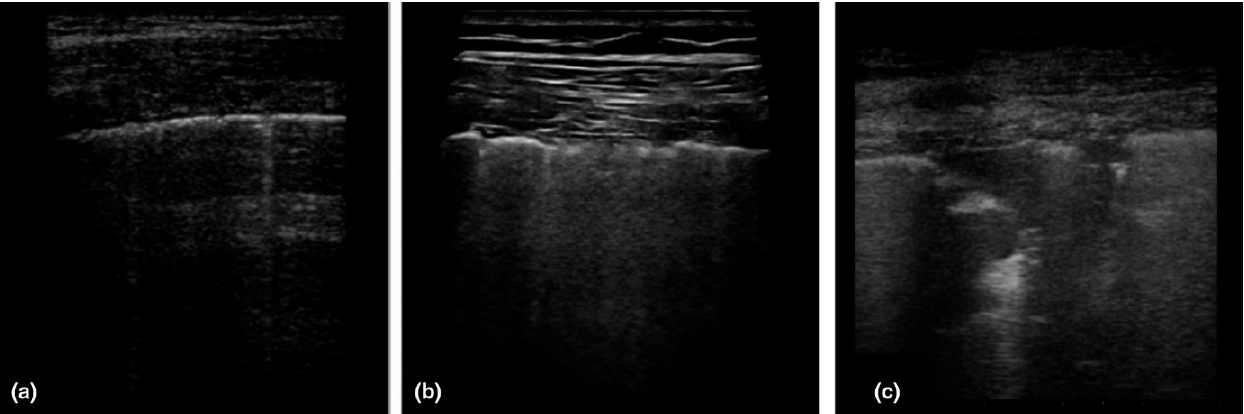
Figure 4. Patterns of COVID-19 at chest ultrasound. ( a ) Early bilateral multifocal areas of interstitial syndrome, ( b ) Interstitial pneumonia characterized by interstitial syndrome with B lines and pre- served sliding sign, ( c ) Advanced, and organized pneumonia with interstitial syndrome associated with multiple subpleural consolidations and reduced sliding sign. Reproduced with permission.